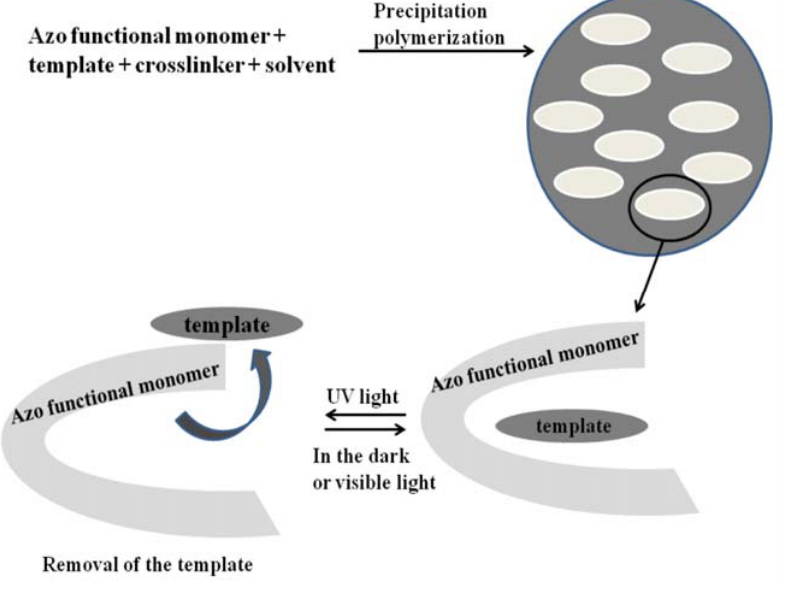
Figure 22. Representation of preparation of azo-containing MIP microspheres with photo-responsive binding